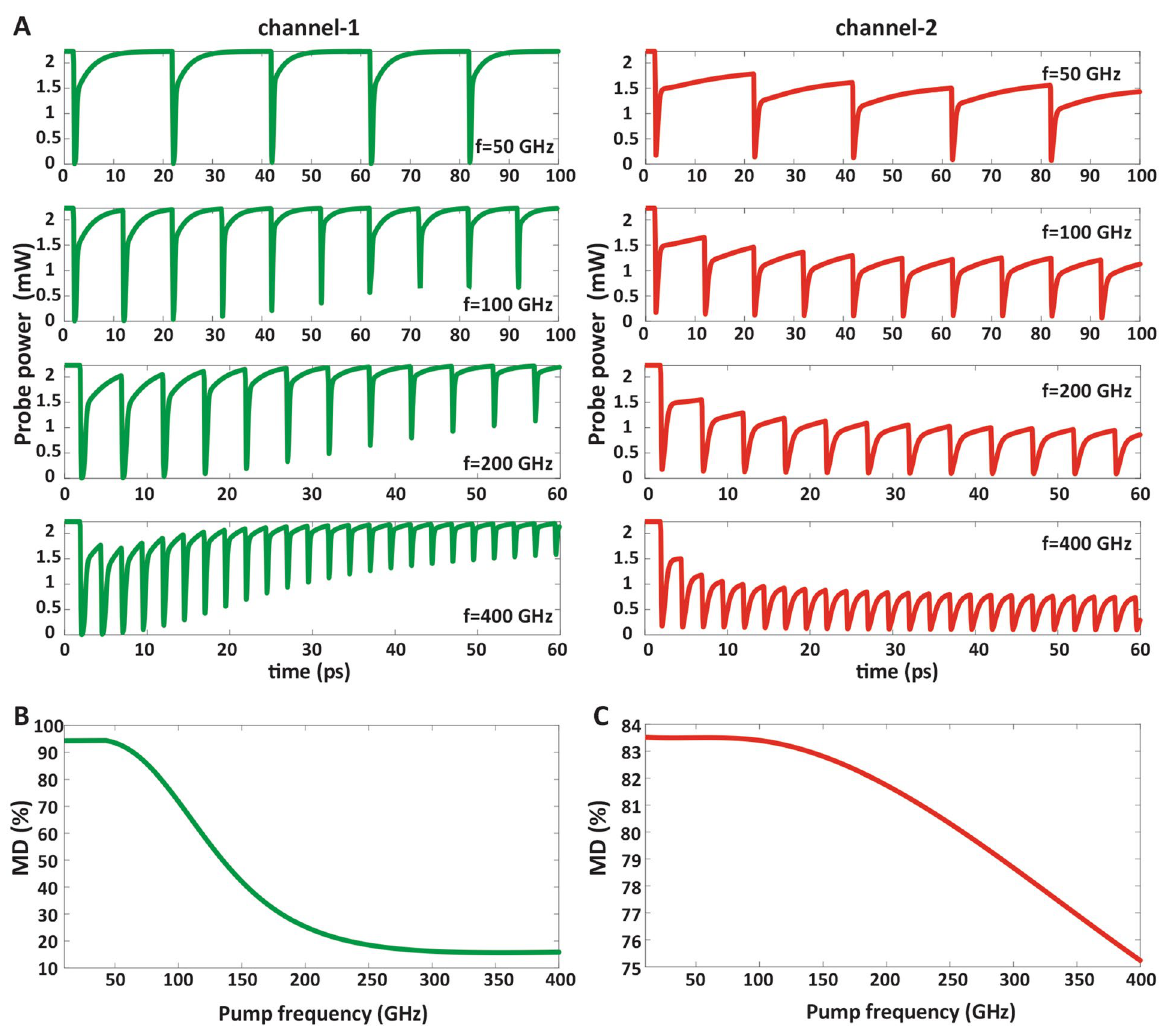
Figure 5. The dependance of MD on the frequency of applied pump power. ( A ) The output modulated probe power at different frequencies, which is indicated that by increasing the modulation frequency, MD and the dynamic range between P ON and P OFF in the probe power signal decreases. ( B ) The MD as a function of pump power frequency at the pump power densities of 300 Wcm −2 and 500 Wcm −2 for channel-1 and ( C ) for channel-2, respectively and probe power of 3 mW for both channel-1 and